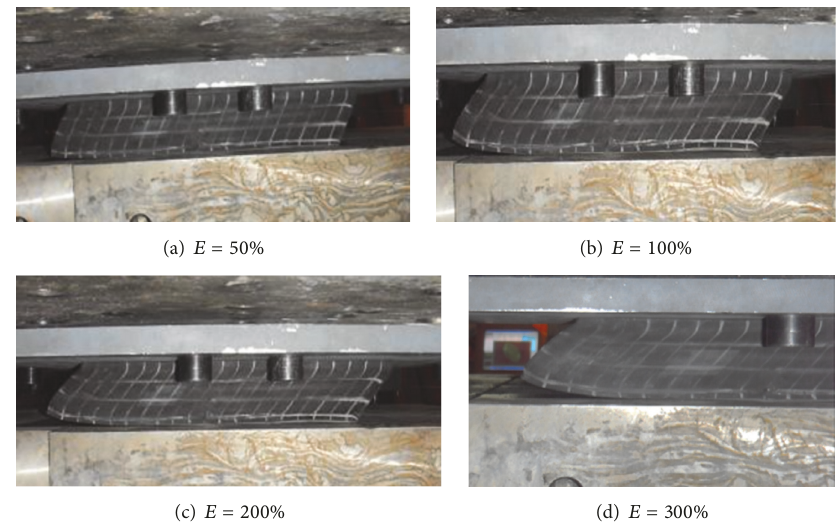
Figure 6: Friction sliding phenomenon (M-2).